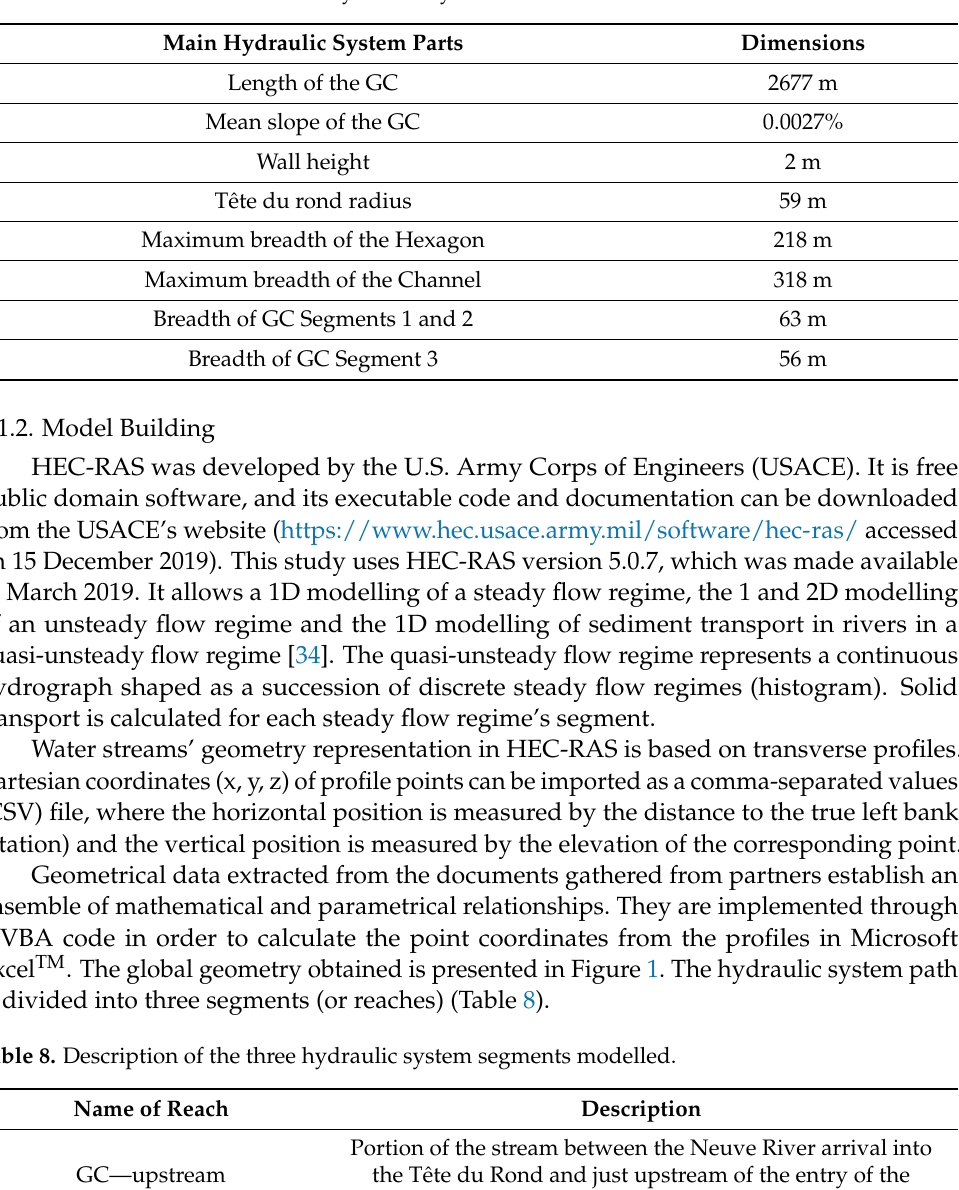
Table 7. General dimensions of the hydraulic system used in HEC-RAS.